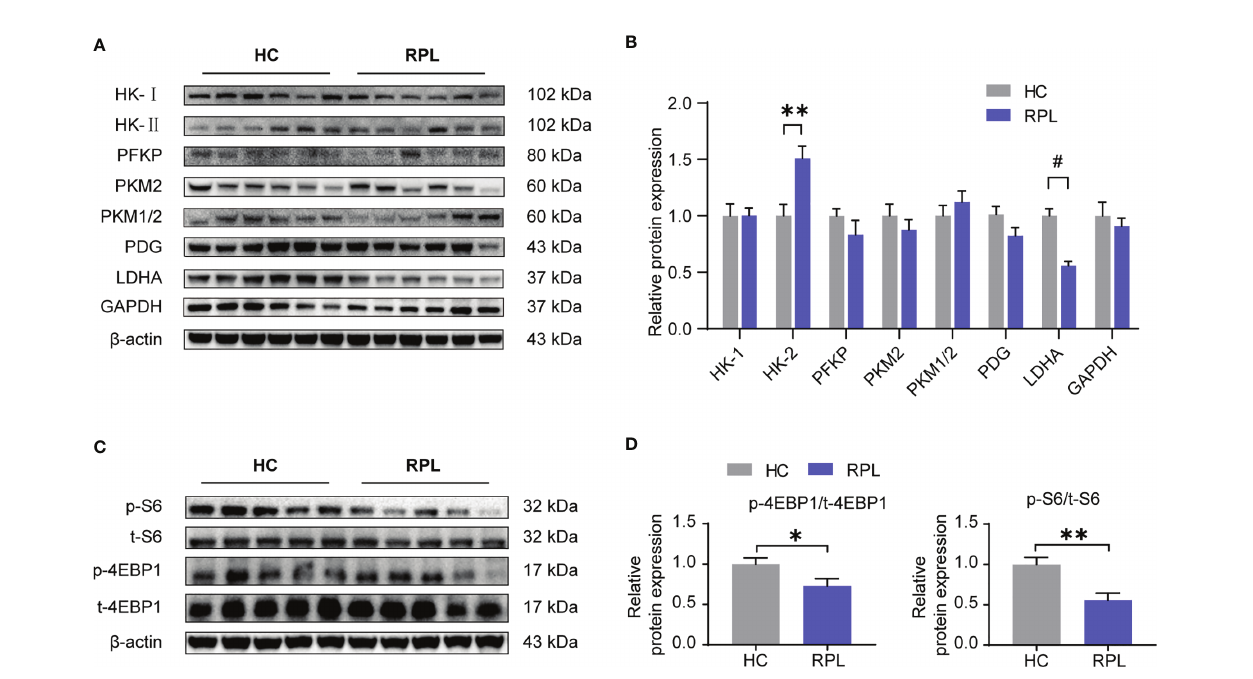
FIGURE 6 | Expression of glycolysis enzymes was altered and the mTORC1 signaling pathway was downregulated in RPL decidua. (A, B) Western blotting and quantitative results of glycolysis-associated enzymes and GAPDH in the decidua of women with normal early pregnancies (n = 15) and those with recurrent pregnancy loss (RPL) (n = 19). HC, health control; RPL, recurrent pregnancy loss (unpaired t-test). (C, D) Western blot analysis the mTORC1 activity in some samples described as above. Also, phosphorylated S6 ribosomal protein(p-S6)/total S6 and phosphorylated eukaryotic translation initiation factor 4E-binding protein 1 (p-4EBP1)/total 4EBP1 expression were analyzed by densitometry method (n = 6 for both groups, unpaired t test). * P < 0.05, ** P < 0.01, and # P <